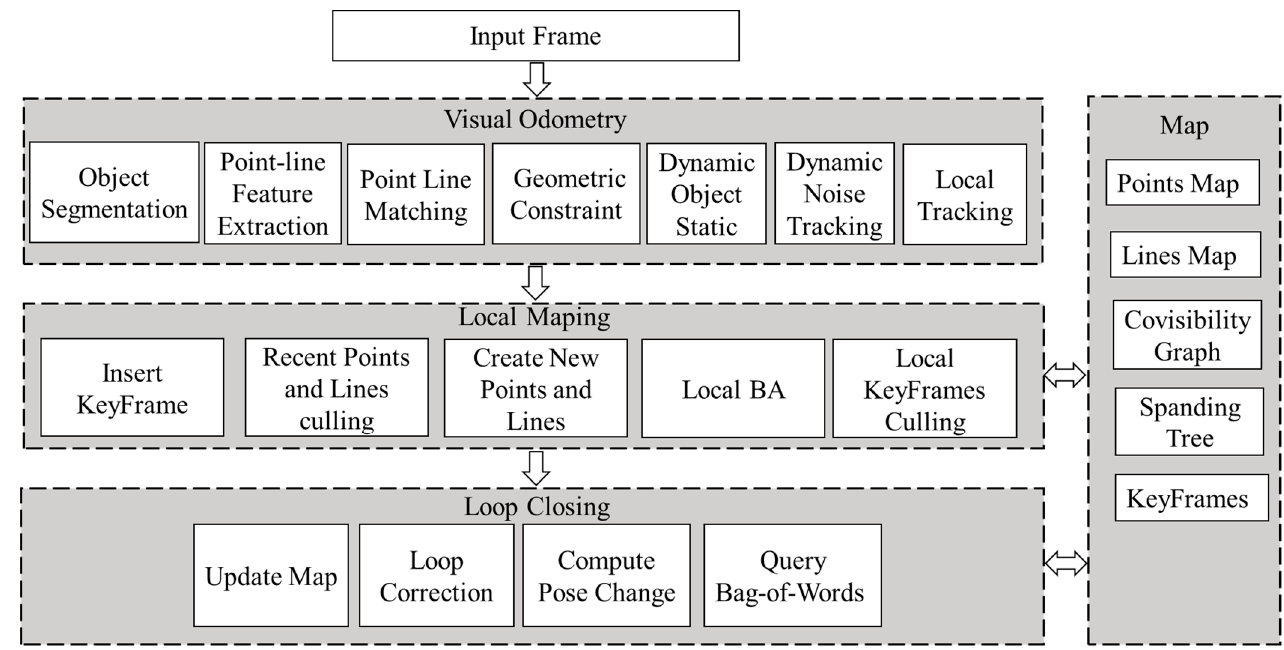
Figure 1. Block diagram of PLDS-SLAM algorithm based on point-line features.